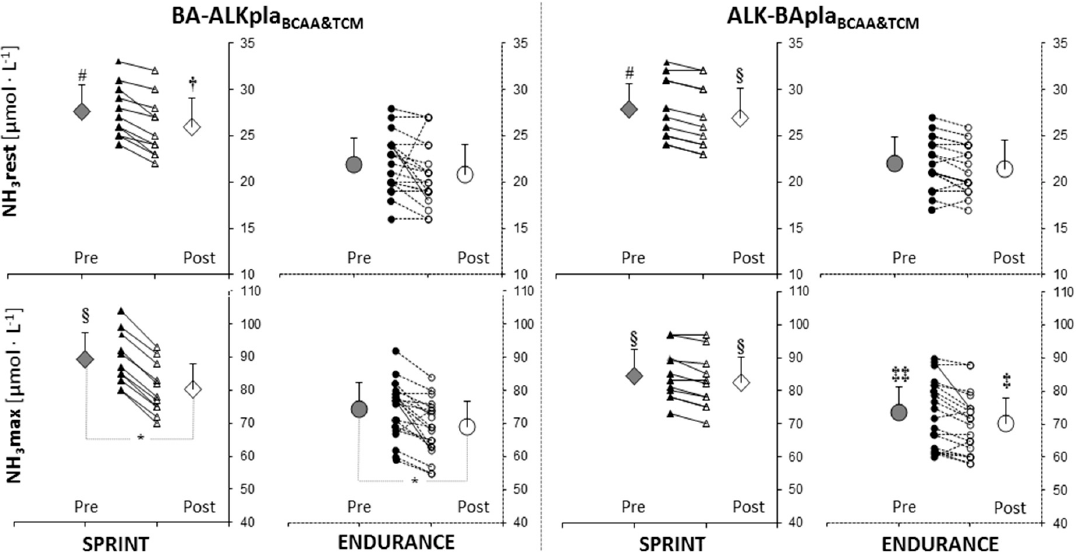
Figure 3. Resting and maximum post-exercise blood ammonia (NH 3 ) concentration before and after supplementation. *: significant di ff erence between “Pre” and “Post” values ( p < 0.001); #,§: significantly di ff erent from the endurance group for all periods (# p < 0.001, § p < 0.01; † : significantly di ff erent from the endurance group for BA-ALKpla BCAA&TCM periods and “Post” ALK-BApla BCAA&TCM ( p < 0.05); ‡: signi fi cantly di ff erent from the endurance group for “Pre” BA-ALKpla BCAA&TCM period ( p < 0.05); ‡‡: signi fi cantly di ff erent from the endurance group for “Post” BA-ALKpla BCAA&TCM period ( p < 0.05).